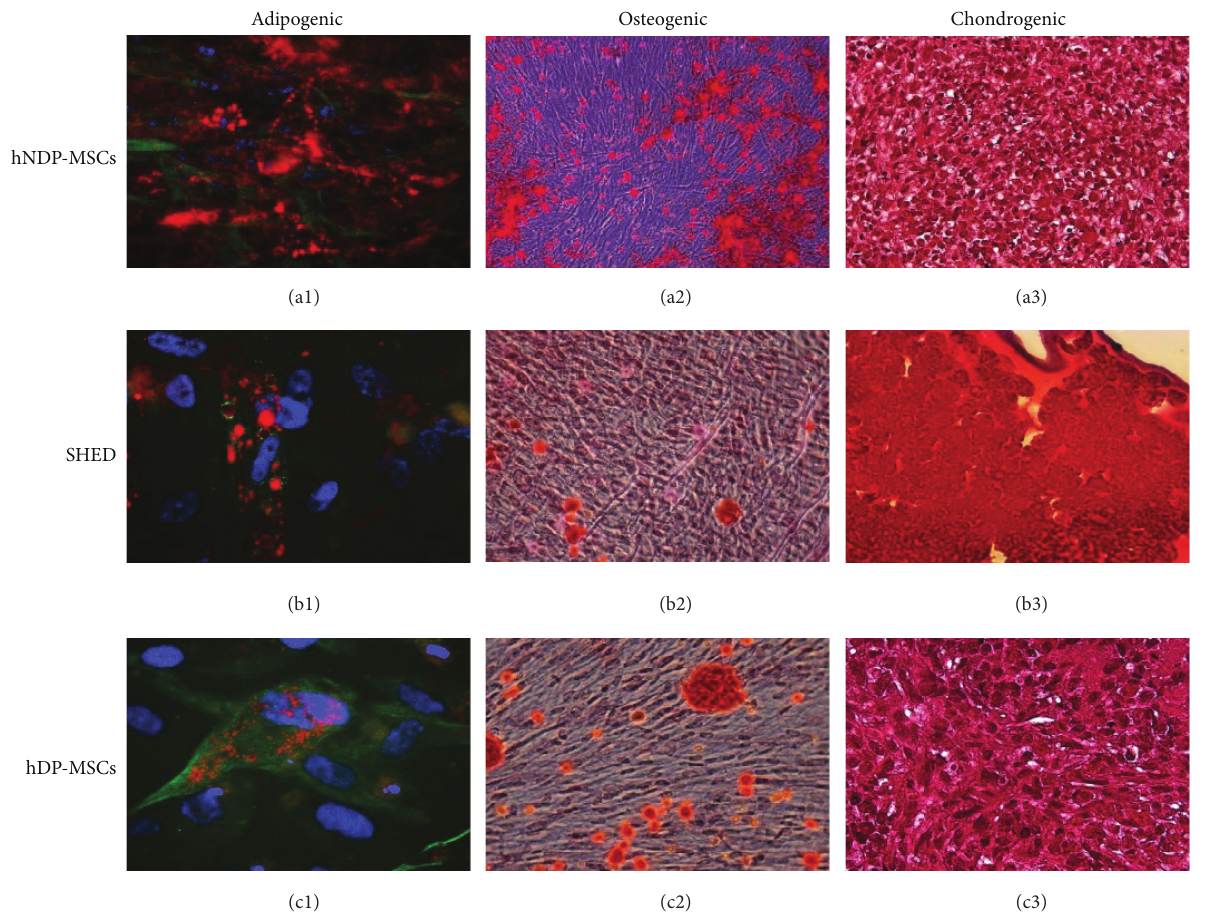
Figure 4: In vitro differentiation potential of NDPSCs, SHED, and DPSCs. ((a1), (b1), and (c1)). Adipogenic differentiation is visually marked by accumulation of neutral lipid vacuoles in cultures (Oil Red staining). Actin ((a1) and (b1)) and vimentin (c1) expression were shown in green and nuclei in blue with DAPI. ((a2), (b2), and (c2)) Osteogenic differentiation was indicated by the formation of calcified nodule with Alizarin Red S staining. ((a3), (b3), and (c3)) The analyzed sections were positive for Safranin O staining after chondrogenic